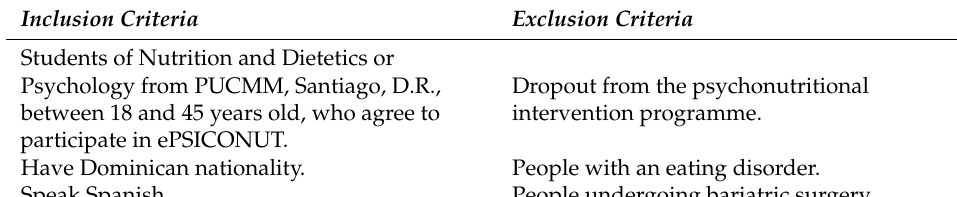
Table 1. Inclusion and Exclusion Criteria of ePSICONUT programme.